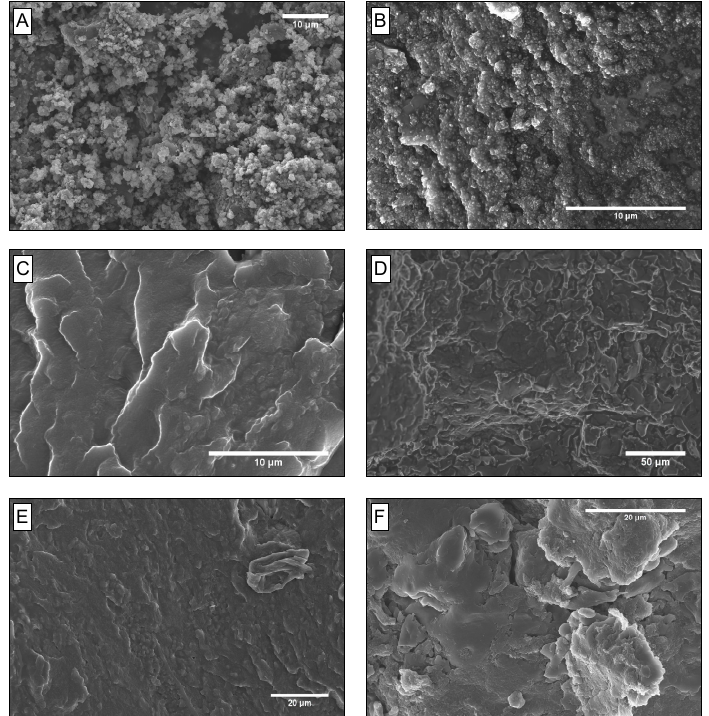
Figure 4. SEM imaging of the cryo-fractured surface of ( A ) TANI in the emeraldine salt oxidation state ( B ) 25 mol% TANI-SBS, ( C ) 35 mol% TANI SBS, ( D ) 50 mol% TANI-SBS, ( E ) 25 mol% TANI-PB and ( F ) 50 mol% TANI-PB.